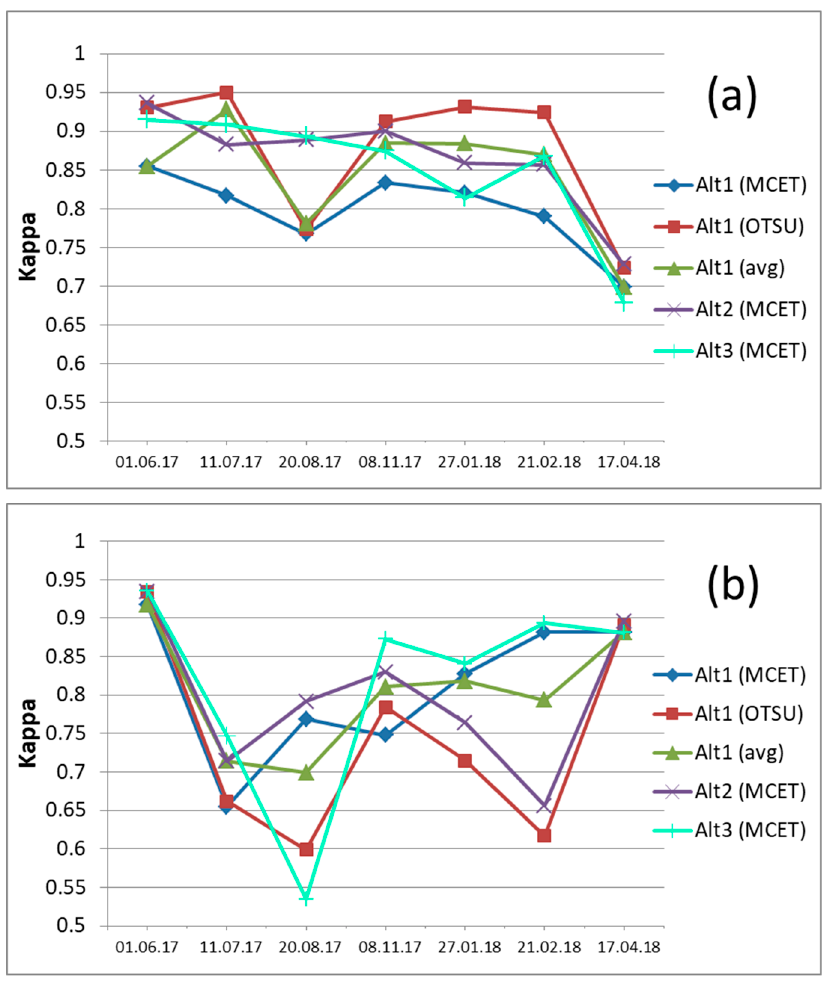
Figure 8. Kappa coefficient variation of five alternatives for seven different dates with respect to ( a ) Figure 8. Kappa coe ffi cient variation of five alternatives for seven di ff erent dates with respect to Doñana marshland and ( b ) Doñana complete area. ( a ) Doñana marshland and ( b ) Doñana complete